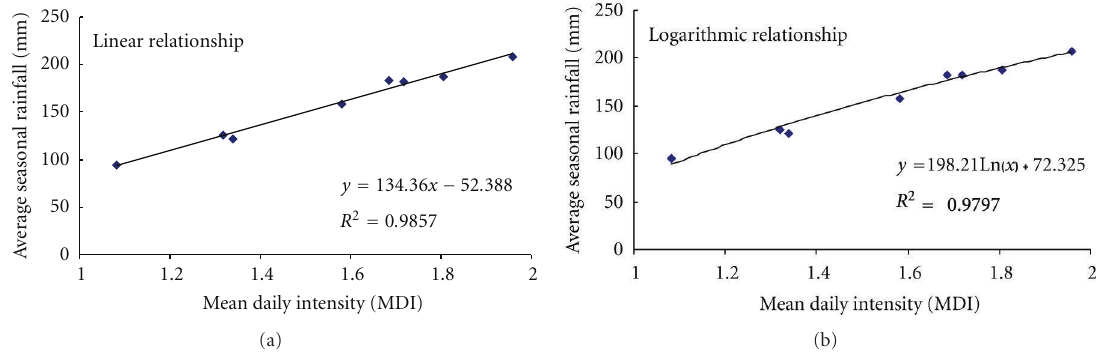
Figure 11: Relationship between Average seasonal rainfall and Mean daily intensity (a) Linear relationship (b) Logarithmic